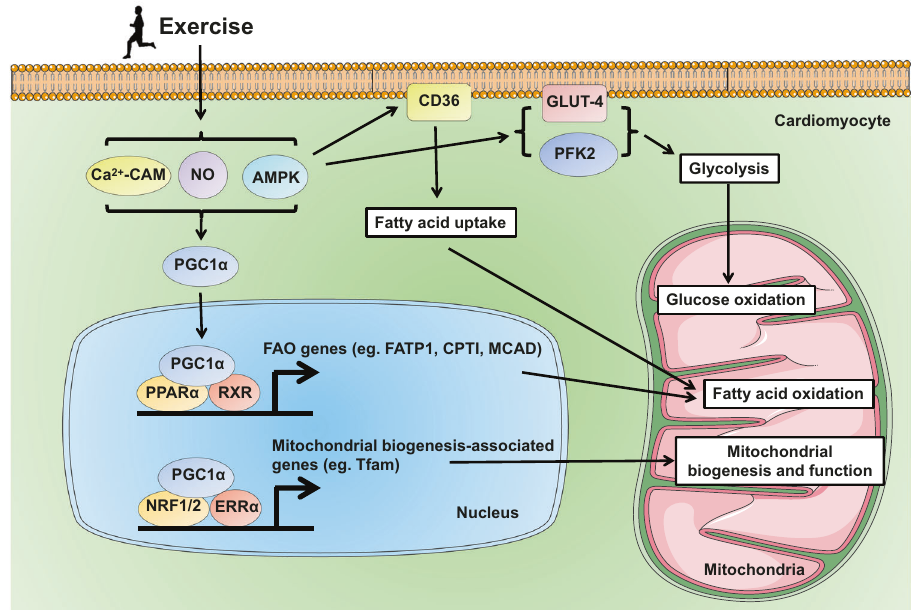
Fig. 4 The PPAR, PGC1 α , AMPK signaling network in exercise-induced metabolic changes and exercise-induced cardioprotection. Exercise triggers an increase in NO production, Ca 2 + -Calmodulin kinase interaction, and AMPK activation, leading to PGC1 α upregulation and activation in cardiac muscle cells. The PGC1 α may form transcriptional regulatory complex with PPAR α and RXR, or coactivate other transcriptional partners such as NRF-1/2 and ERR, to promote downstream transcription of genes involved in fatty acid oxidation and mitochondrial biogenesis/energy metabolism, respectively. Exercise-induced AMPK may modulate glucose uptake, glycolysis and glucose oxidation, and may modulate fatty acid utilization including fatty acid uptake, translocation to mitochondrial, and fatty acid oxidation as well. PPAR α peroxisome proliferator-activated receptor α , PGC1 α peroxisome proliferator-activated receptor-alpha coactivator 1 α , AMPK adenosine monophosphate-activated protein kinase, CAM calmodulin, NO nitric oxide, RXR retinoid X receptor, NRF1/2 nuclear respiratory factor-1 and 2, ERR α estrogen-related receptor α , FAO fatty acid oxidation, FATP1 fatty acid transport protein 1, CPTI carnitine palmitoyltransferase I, MCAD medium-chain acyl-CoA dehydrogenase, Tfam nuclear-encoded mitochondrial transcription factor A, PFK2